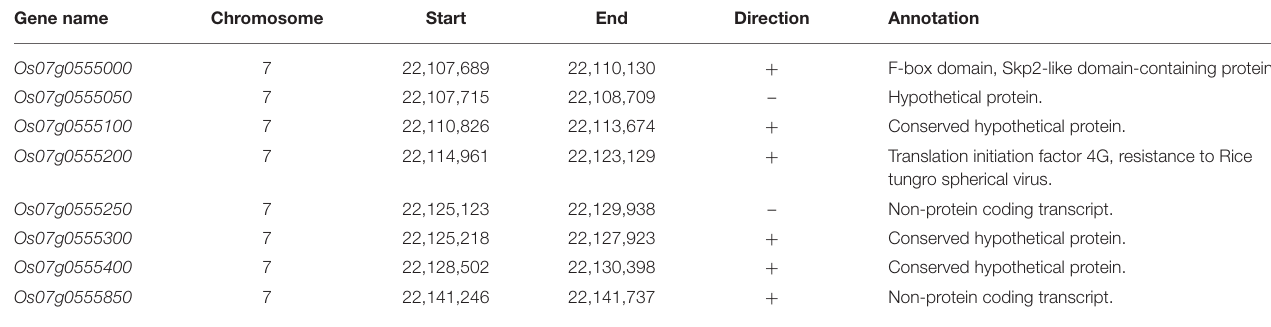
F-box domain, Skp2-like domain-containing